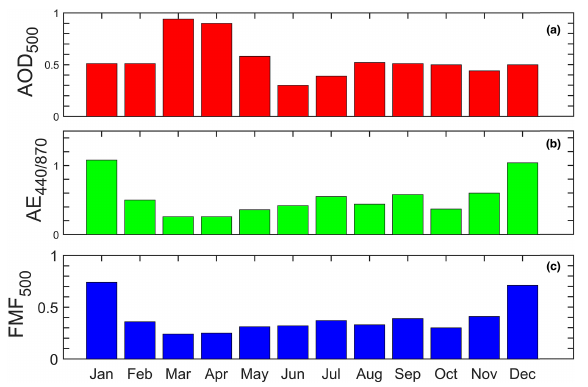
Figure 2. Monthly means of (a) the AOD at 500nm, (b) Ångström exponent (440–870) and (c) fine mode fraction (FMF) at 500nm from 2013 to 2017. The data are obtained from the SONET